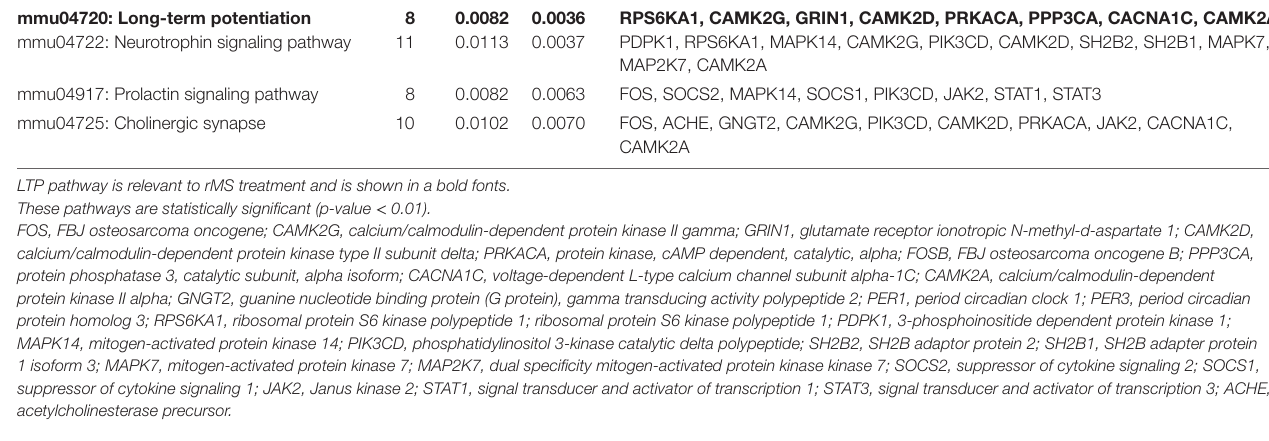
TaBle 2 | The enriched Kyoto Encyclopedia of Genes and Genomes pathways in high-frequency group compared with low-frequency group. Term count % p -Value genes mmu05031: Amphetamine